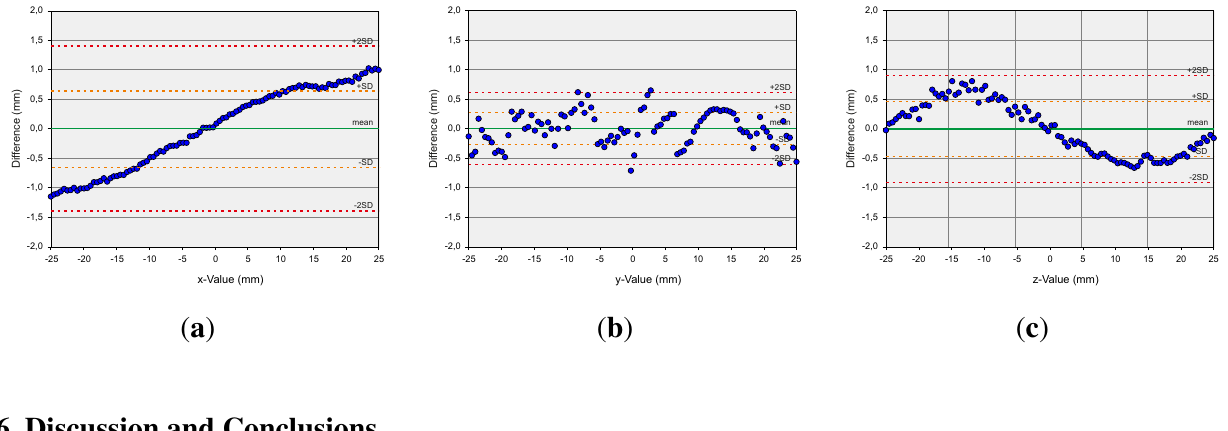
Figure 10. Analysis of Accuracy as Bland–Altman Plots for a Sinus Shaped Motion of the Test Bar of the Robot for a measuring range from − 25 mm to 25 mm . ( a ) x-Deviation; ( b ) y-Deviation; ( c )